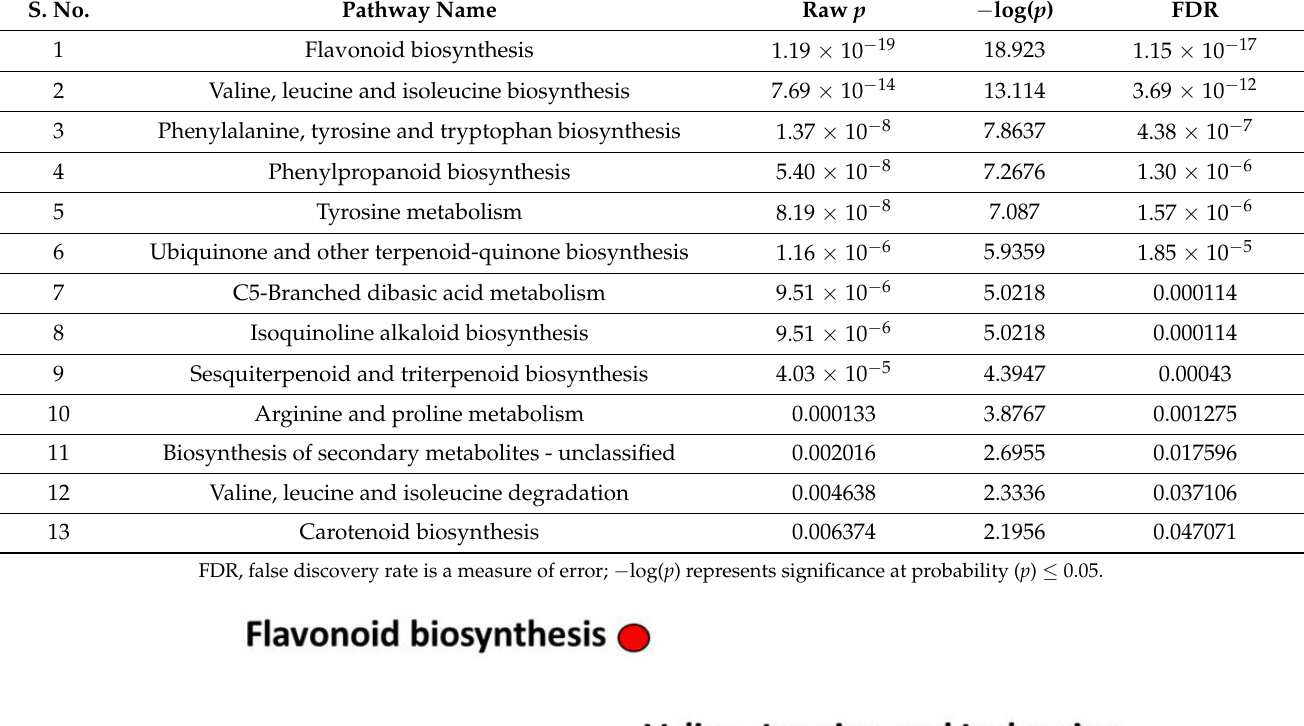
Table 2. List of metabolic pathways significantly contributing to grain color diversity. S. No.